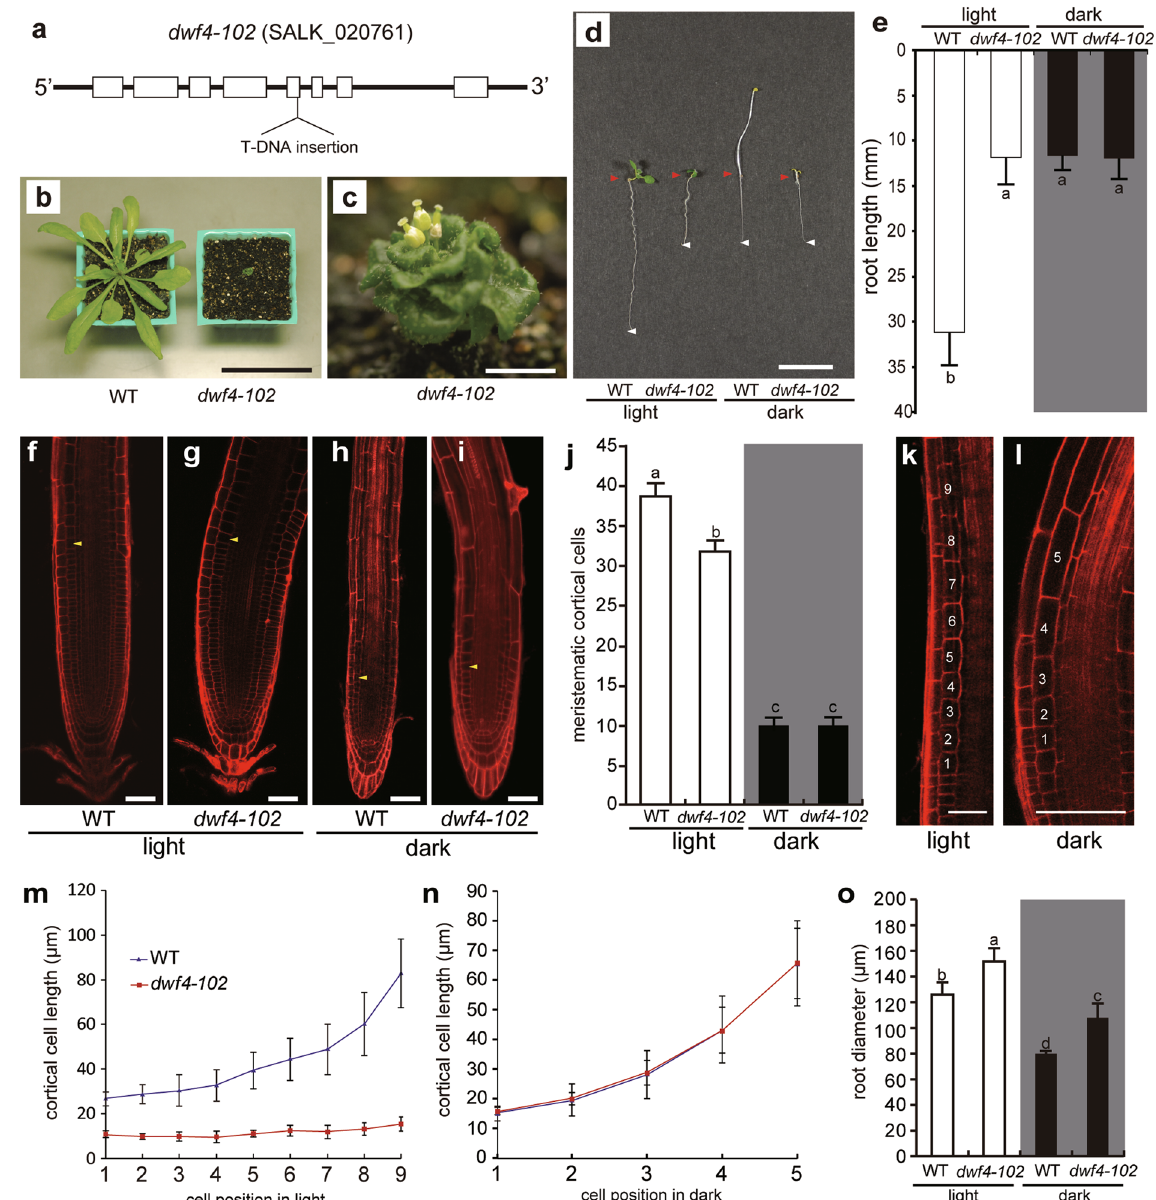
Figure 1. dwf4-102 mutants. ( a ) The dwf4-102 mutant plants contained a T-DNA insertion in the fifth exon of the DWF4 gene. These plants exhibited dwarfism during the vegetative stage ( b ) and produced defective flowers during the reproductive stage ( c ). The roots of dwf4-102 plants were relatively short under light and dark conditions ( d , e ) [wild-type (WT): n = 48; dwf4-102 : n = 16]. Samples were stained with propidium iodine for analyses of the root apexes of WT ( f , h ) and dwf4-102 mutants ( g , i ) incubated under light ( f , g ) or in darkness ( h , i ). Arrowheads indicate the first cell of the elongation zone. Root diameters were measured in the region corresponding to the first cell of the elongation zone. ( j ) Cell division activity in the root apical meristems. The cortical cells were counted. There were no differences between WT and dwf4-102 plants incubated in darkness [WT: n = 42; dwf4-102 : n = 24]. ( k – n ) Cell elongation activity in root tips. Under light conditions, cell elongation was observed in WT plants but not in dwf4-102 plants ( k , m ) [WT: n = 16; dwf4-102 n = 12]. On the other hand, the number of cells in the elongation zone was reduced, and there were no differences between WT and dwf4-102 plants incubated in darkness ( l , n ) [WT: n = 16; dwf4-102 : n = 12]. ( o ) Root diameter. The roots of dwf4-102 plants were thicker than those of the WT plants under light and dark conditions [WT: n = 40; dwf4- 102 : n = 15]. Means denoted by the same letter are not significantly different (P < 0.05) according to the Tukey– Kramer method ( j , o ). Scale bars represent 50 mm ( b ), 10 mm ( c , d ), and 50 µ m ( f – i , k , l ). Error bars represent standard